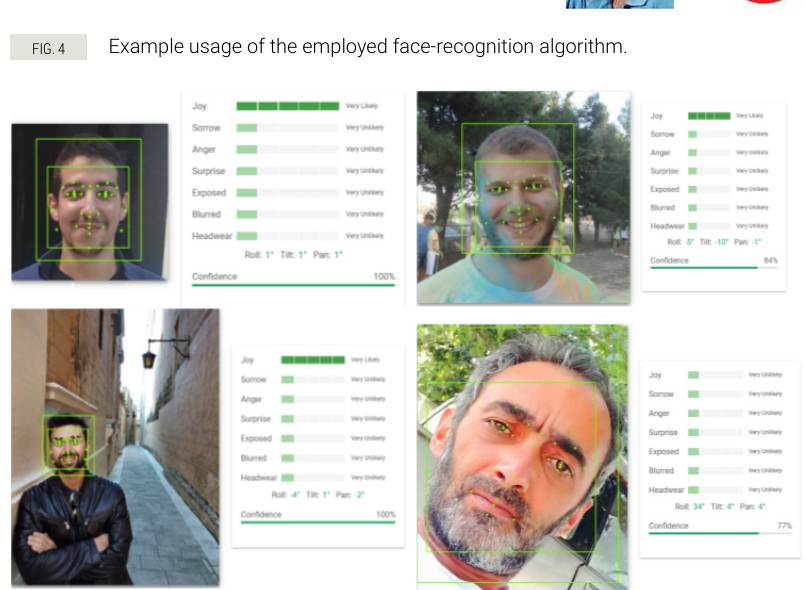
Illustrating facial landmark detection and emotion recognition by the employed CV